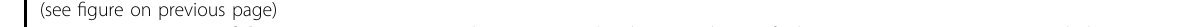
Fig. 2 Consequences of the Der1 mutation. a Top relevant canonical pathway predictions for heterozygous Der1 cortex using whole gene, DESeq2 or whole gene and exon-level, DESeq2 + DEXSeq data. Asterisks indicate pathways highlighted in both cases. Where IPA predicts a direction of change, this is indicated by a z score, with positive z scores indicating upregulation. b Altered gene expression in the ‘ CREB signalling in neurons ’ canonical pathway in heterozygous Der1 cortex, determined using the whole gene and exon-level DESeq2 + DEXSeq data. To provide additional information, genes encoding calcium channels (CaCh), metabotropic glutamate receptors (mGLUR), ionotropic glutamate receptor subunits (iGLUR) and structural synaptic components have been added to the pathway using the IPA ‘ Build ’ tool. Transcripts encoding components from the whole pathway are dysregulated at the whole gene and/or isoform level, including ionotropic AMPA and NMDA glutamate receptor subunits, metabotropic glutamate receptors and voltage-gated calcium channels, all of which can control the calcium ion in fl ux or G-protein activation that initiates the pathway. Genes encoding several synaptic scaffolds that are required to generate and maintain synapse structure/size and/or anchor glutamate receptors and calcium channels are also dysregulated, including Shank1, Homer1 and Dlg1/3/4, neurexins and neuroligins. Also dysregulated are genes encoding various factors downstream of glutamate receptors and calcium channels that activate the cAMP-dependent transcription factor CREB, such as various forms of Camk2 and adenylyl cyclases. The transcriptional machinery is additionally affected, including the cAMP-dependent transcription factor complex. Double outlines indicate protein complexes and classes, the components of which can be found in Supplementary Table 2a, b. Colour intensity represents the strength of gene expression change, with graded colour within double-outlined symbols representing the overall direction of change within protein complexes. Green, downregulated; red, upregulated; *genes identi fi ed by DEXSeq; ** genes identi fi ed by DEXSeq and DESeq2. c Sunburst plots showing SynGO- annotated synaptic functions of the dysregulated proteins found in homozygous Der1 hippocampus synaptosomes (FDR-adjusted p value < 0.05). Note that synaptosomes are enriched for the complete presynaptic terminal, the postsynaptic membrane and the postsynaptic density, as well as membranes originating from organelles such as the Golgi and endoplasmic reticulum 73 . d Quanti fi cation of AMPA and NMDA receptor currents by whole-cell patch clamping of neurons cultured from Der1 hippocampus. Data were analysed by one-way ANOVA, p = 0.03. The horizontal line on graphs for each sample, an average of values; WT wild type, HET heterozygous Der1 , HOM homozygous Der1 , * p <